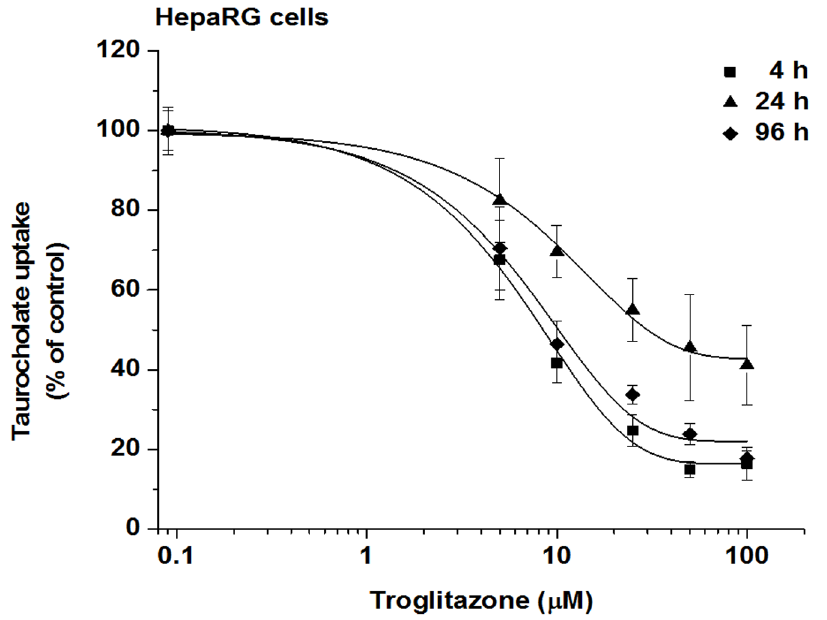
Figure 5. Inhibition of TC uptake by troglitazone in HepaRG cells. HepaRG cells were treated with 1 m M of 3 H-TC for 300 sec at 4, 24 and 96 h after seeding in the presence of troglitazone (5–100 m M), or the vehicle. Values are expressed as mean 6 SD, assays were run using four wells as one set.